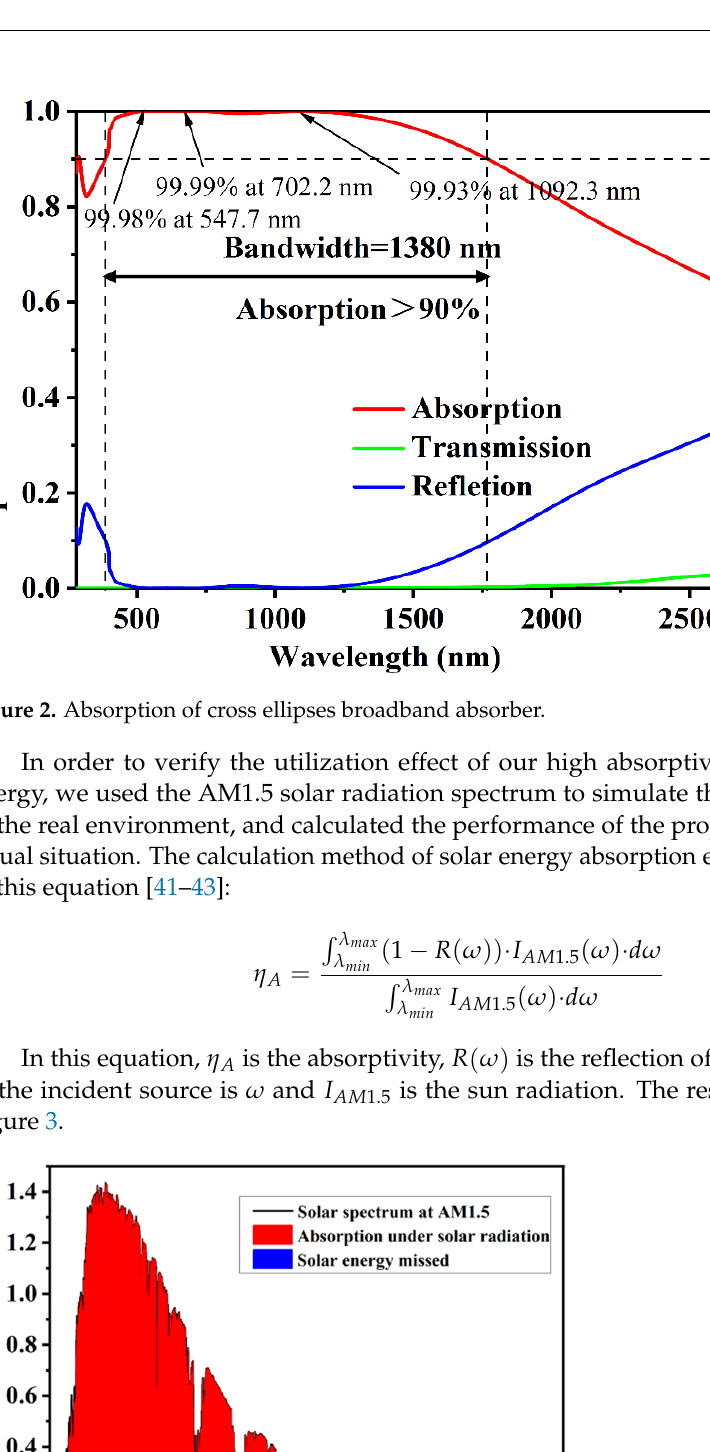
Figure 2. Absorption of cross ellipses broadband absorber.